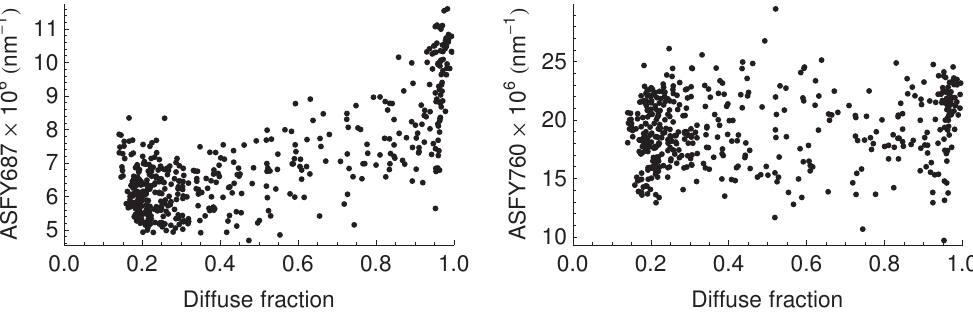
Figure 5. Effect of diffuse fraction of PAR on apparent spectral fluorescence yield of canopy (ASFY687, ASFY760). Only days between DOY 120 (30 Aprill) and DOY 157 (6 June)—when the crop was in a steady state—are considered here to avoid canopy growth effects.